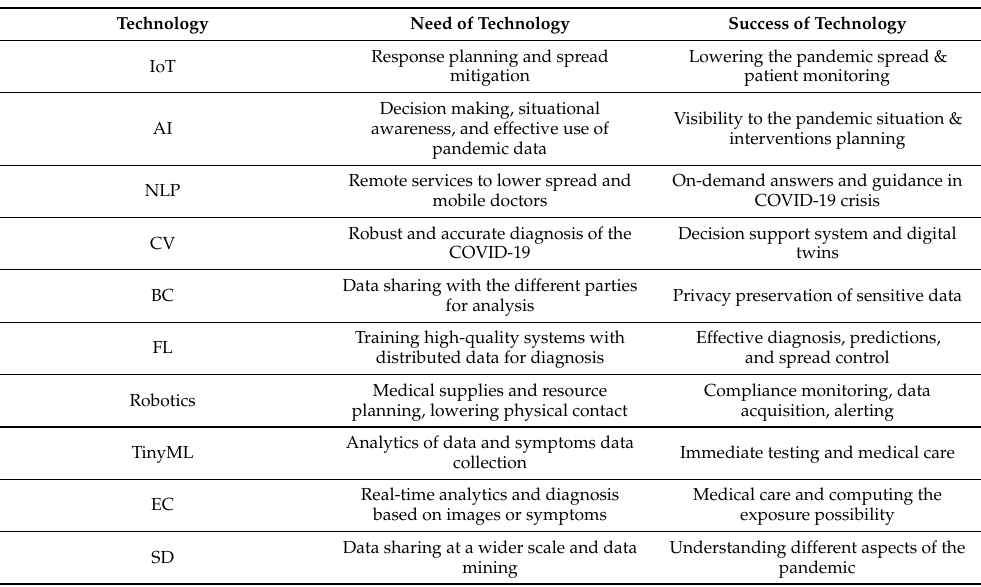
Table 1. Discussion about the need for 10 technologies and how such technologies emerged to be one of the successful technologies to fight